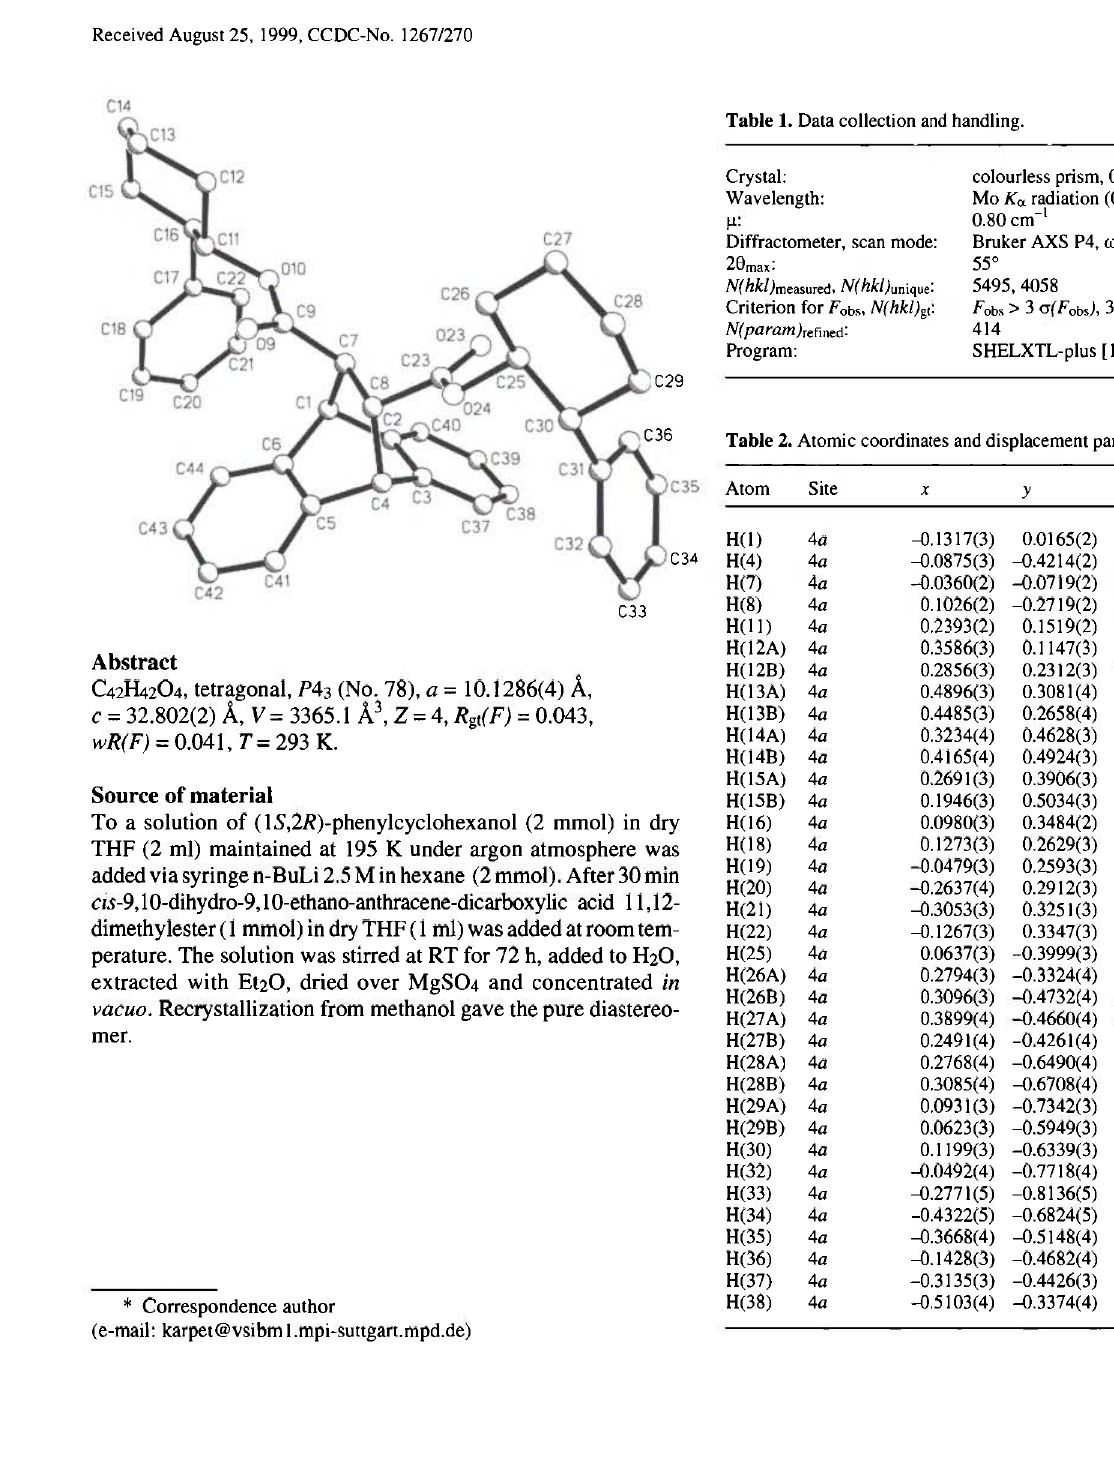
Table 1. Data collection and handling.